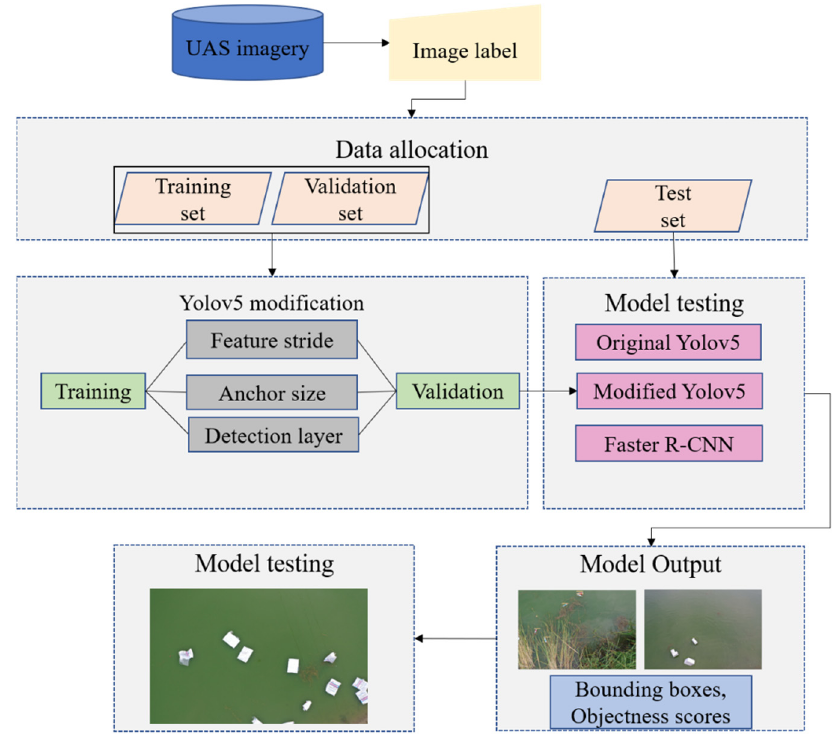
Figure 5. Algorithm block diagram.